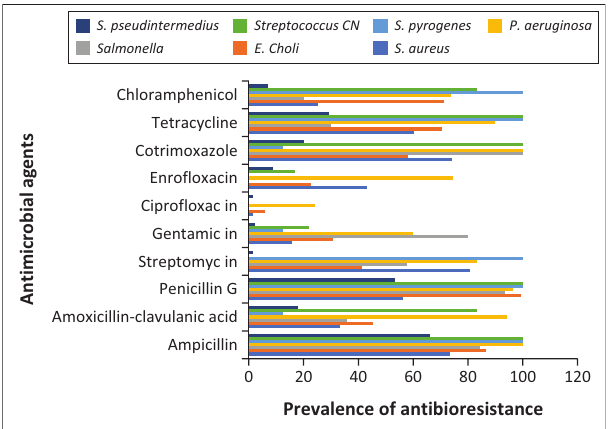
FIGURE 4: Prevalence of multidrug resistant strains in dogs in